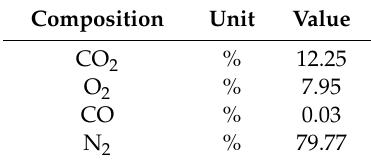
Table 2. Composition of flue